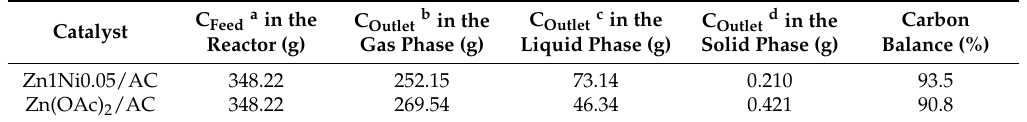
Table 2. Calculation of carbon